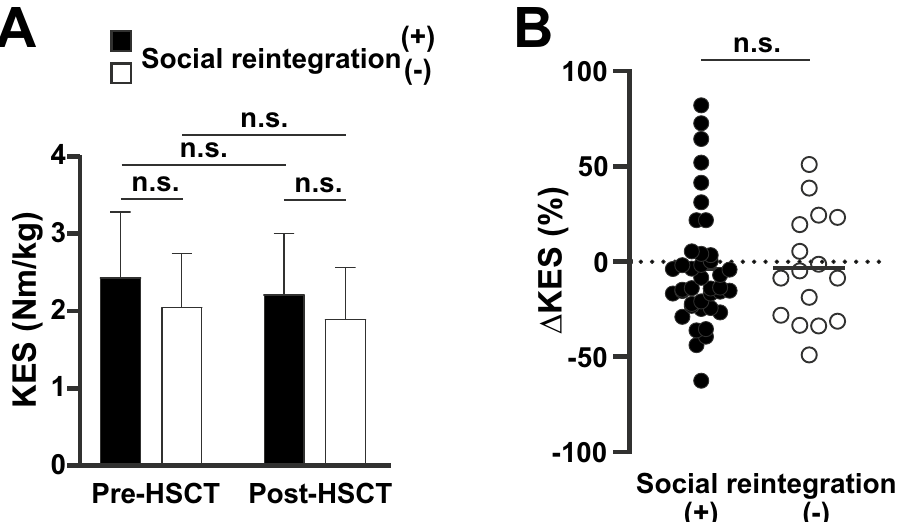
Figure 3. The change of the knee extensor strength (KES) and the correlation with social reintegration. ( A ) Measured KES values (mean ± standard deviation) are shown based on the later social reintegration status at each time-point of pre- and post-HSCT. ( B ) KES changes (ΔKES) are plotted individually. n.s., not significant.